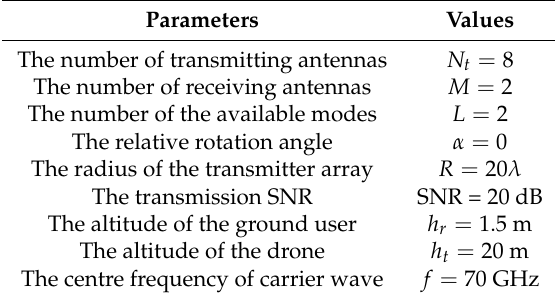
Table 1. Simulation